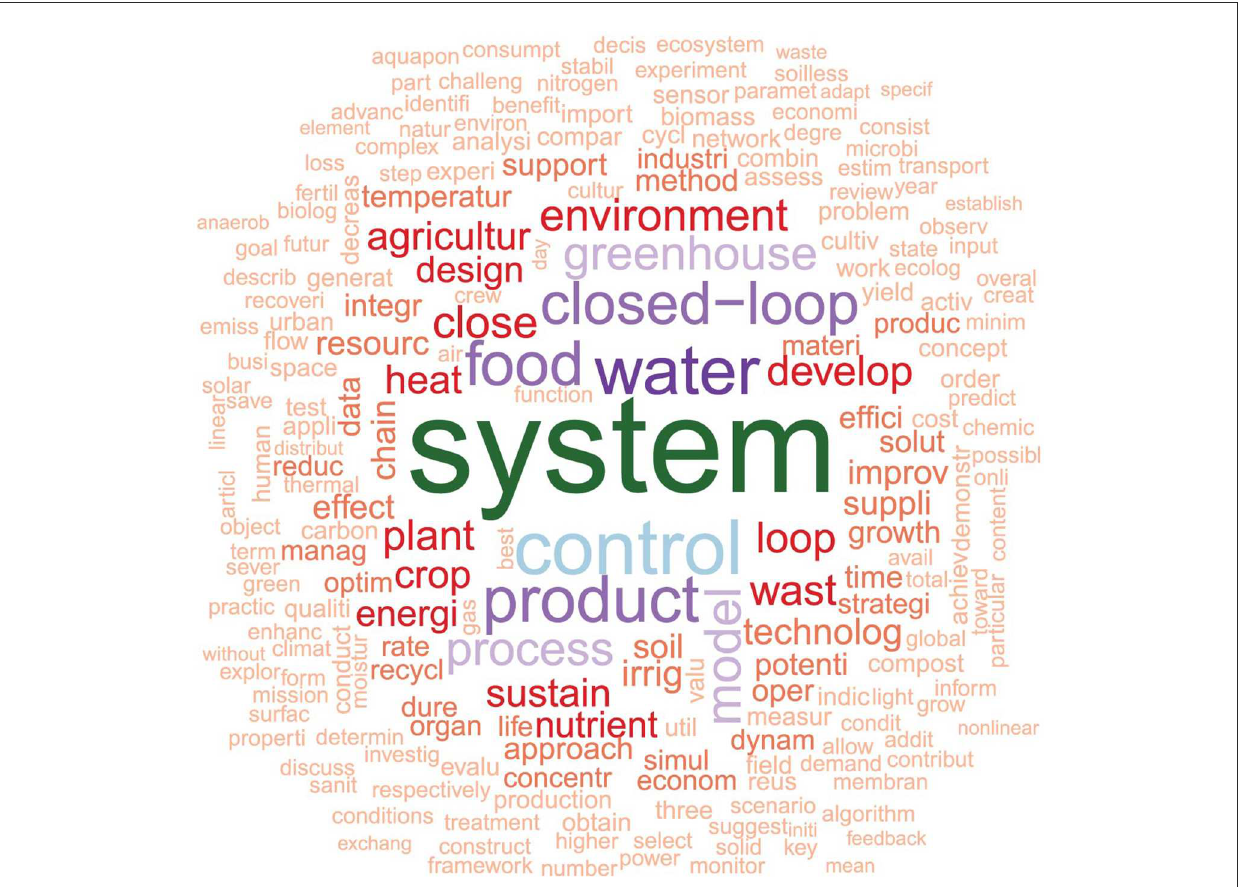
FIGURE3 Illustrated word cloud following the application of all pre-processing steps. Words that occur at a higher rate in the dataset appear in larger fonts within the word cloud, while those that are not as common within the abstracts are smaller in size.